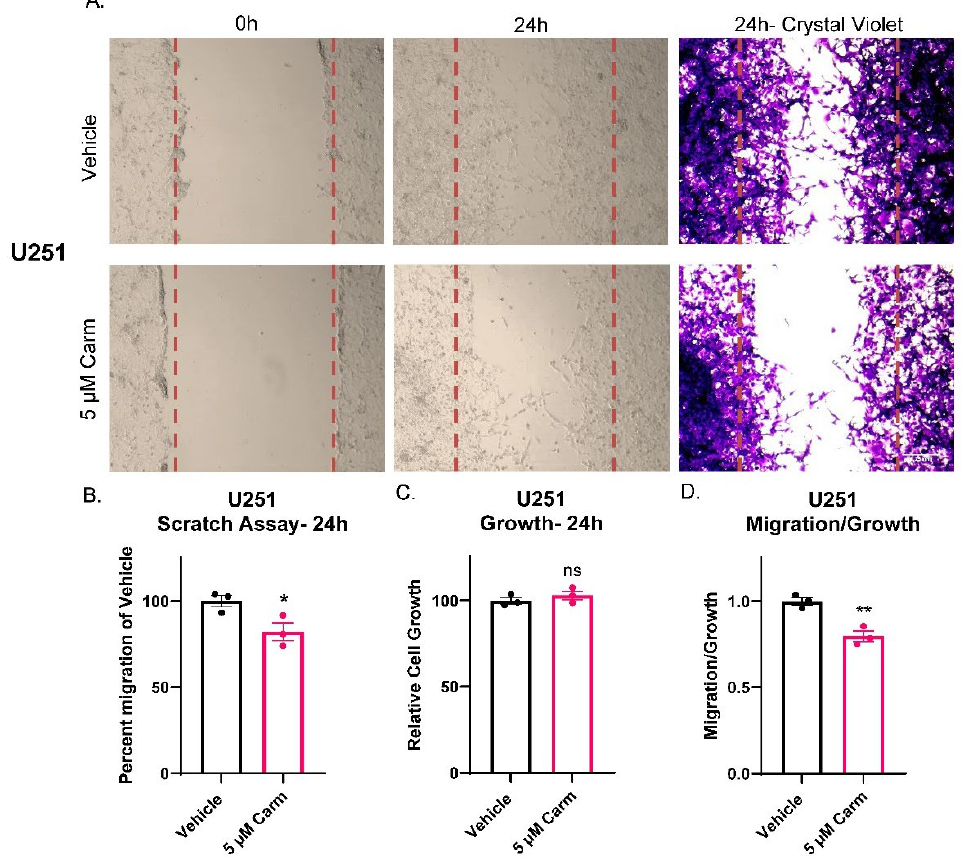
Figure 4. Carmofur decreased migration of U251 GBM cells. Cells were serum-starved in the presence of vehicle (DMSO) or 5 µ M carmofur 16 h prior to introducing the scratch and re-treated at the time of the assay. After 24 h, cells were fixed in formalin and stained with crystal violet. ( A ) Representative images of U251 scratch assays at 0 h, 24 h, and 24 h with crystal violet staining taken at 10 × magnification. ( B ) Image centers of 24 h 20 × images were quantified using particle analysis in ImageJ and normalized to 0 h images before normalizing to vehicle for quantification. Comparison of groups was performed using independent t -test. ( C ) Matching growth was analyzed by Cell Titer Glo and normalized to vehicle control. ( D ) Percent migration was divided by the relative cell growth to determine the ratio of migration to growth. Data are displayed as means ±